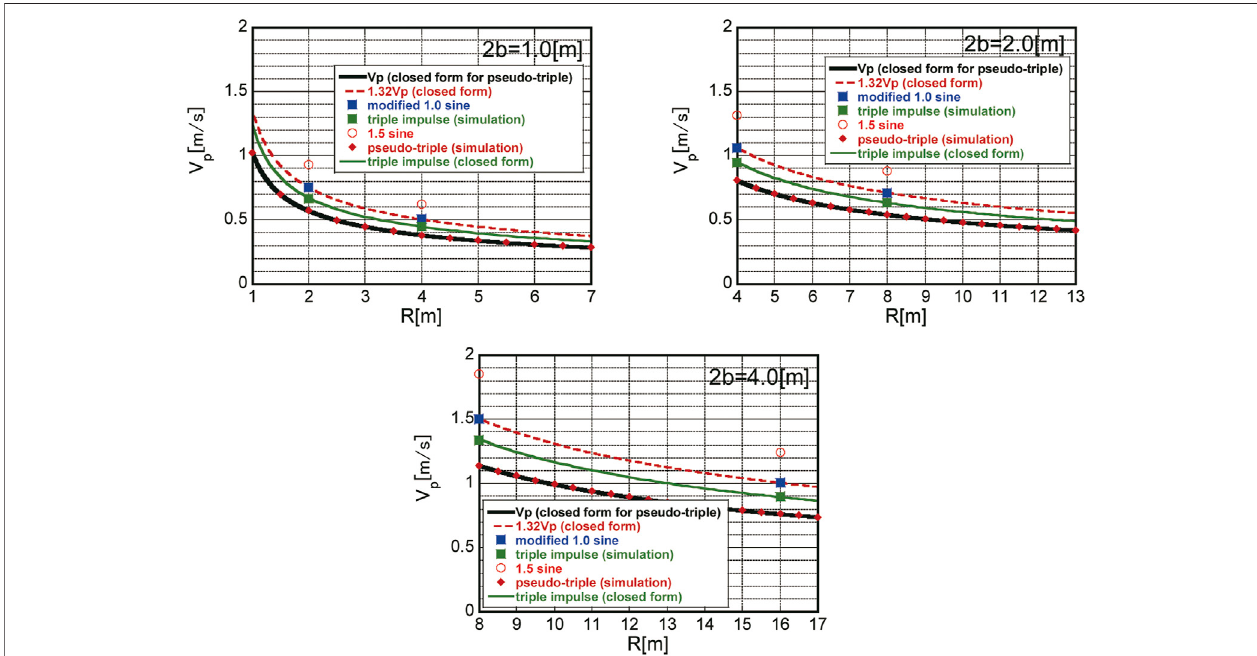
FIGURE13| Comparisonofoverturninglimitvelocityamplitude V P amongclosed-formlimitusingpseudo-tripleimpulse(consistingofthe fi rsttwoimpulsesintriple impulse), triple impulse limit, equivalent modi fi ed 1.0-cycle sinusoidal wave limit, 1.5-cycle sinusoidal wave limit and closed-form limit using triple impulse.